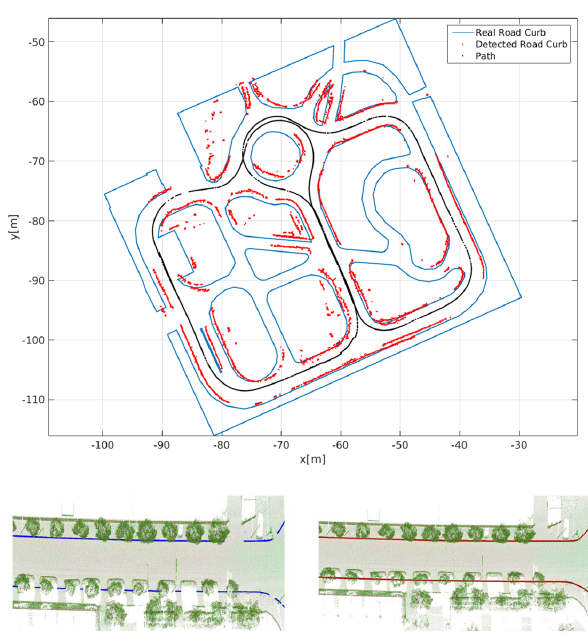
Figure 17. Curb mapping using a vision-based SLAM [1] and GPS